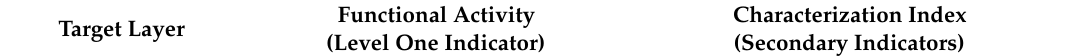
Table 2. Construction of indicators of functional activities of family members in land-lost farmers’